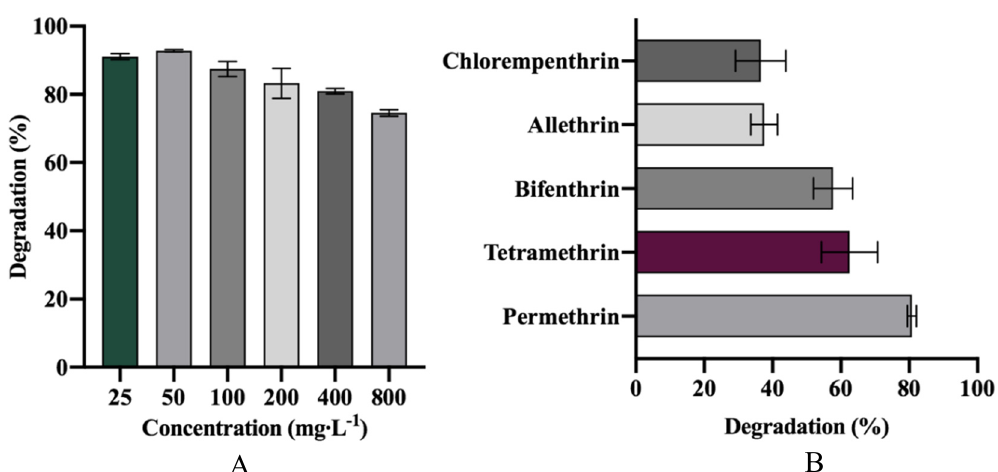
Figure 5. ( A ) Degradation of different initial concentrations of D-cyphenothrin by Staphylococcus succinus HLJ-10; ( B ) Degradation of various pyrethroids by Staphylococcus succinus HLJ-10.